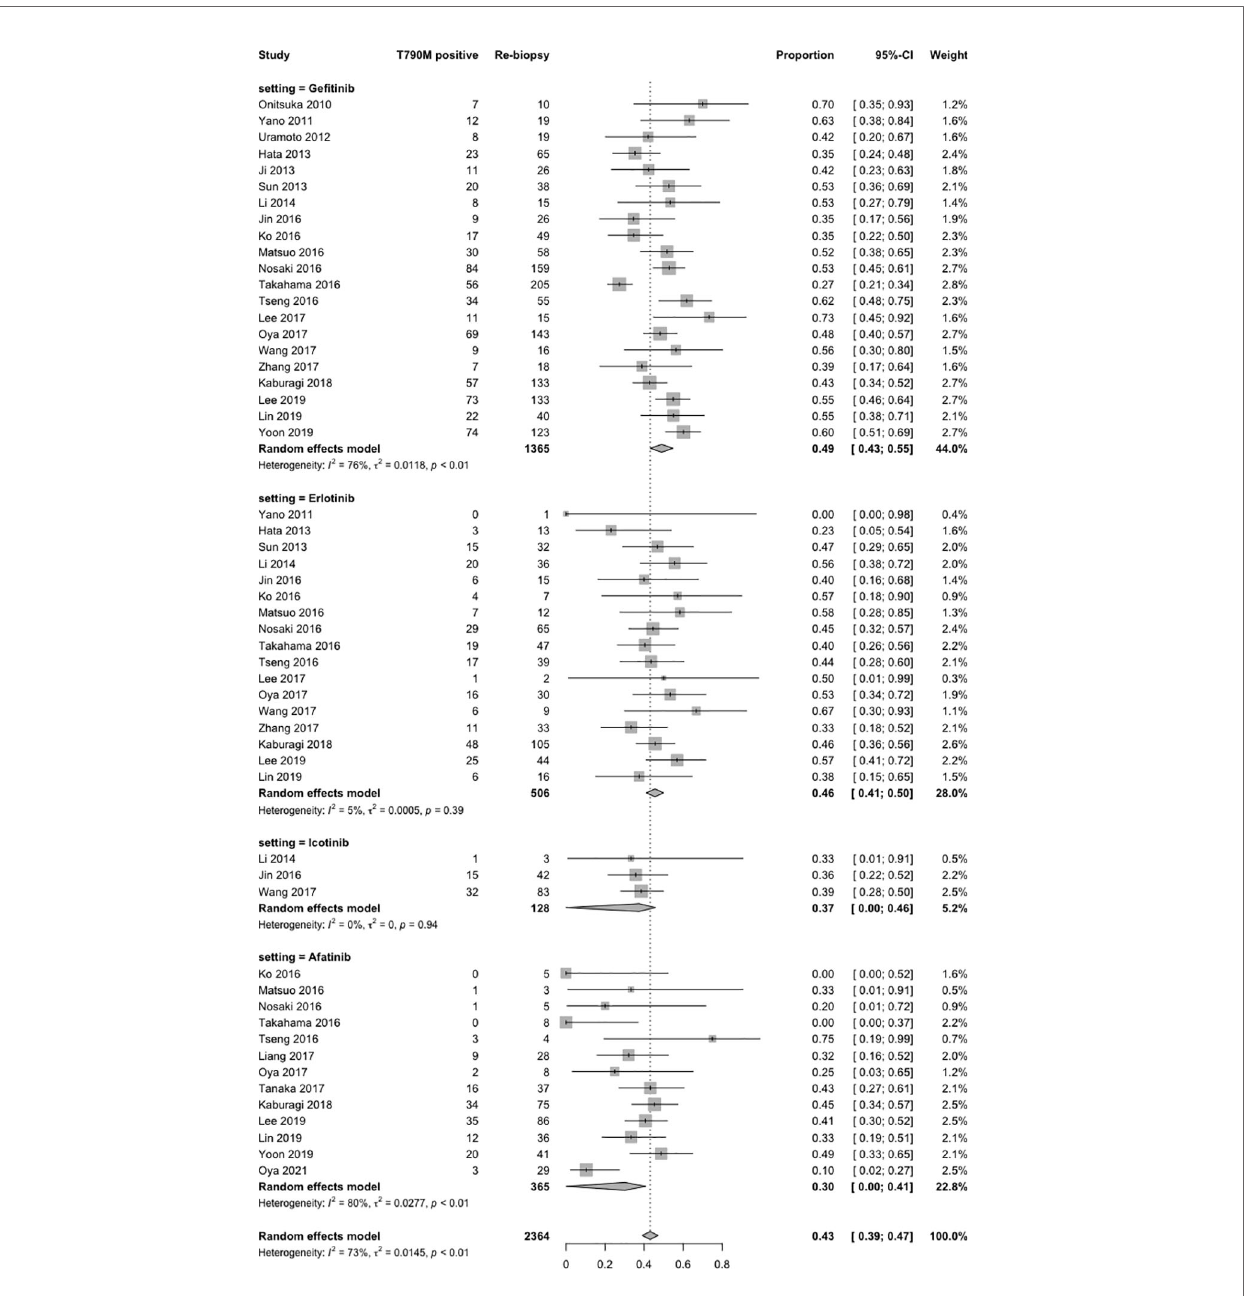
FIGURE 4 | Forest plot of subgroup single-arm meta-analysis of Asian